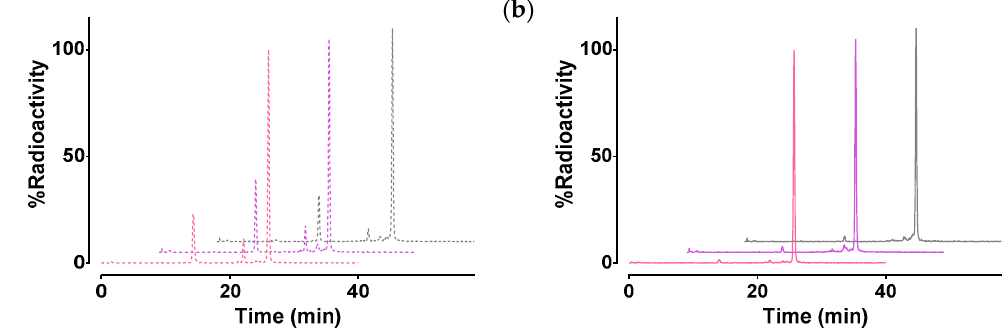
Figure 4. Representative HPLC radiochromatograms (System 2) of mouse blood collected 5 min after iv injection of [ 99m Tc]Tc-DB7 (pink lines), [ 99m Tc]Tc-DB13 (violet lines), and [ 99m Tc]Tc-DB14 (gray lines) ( a ) without (dotted lines) or ( b ) with PA coinjection (solid lines); results represent average values ± SD, n = 3.